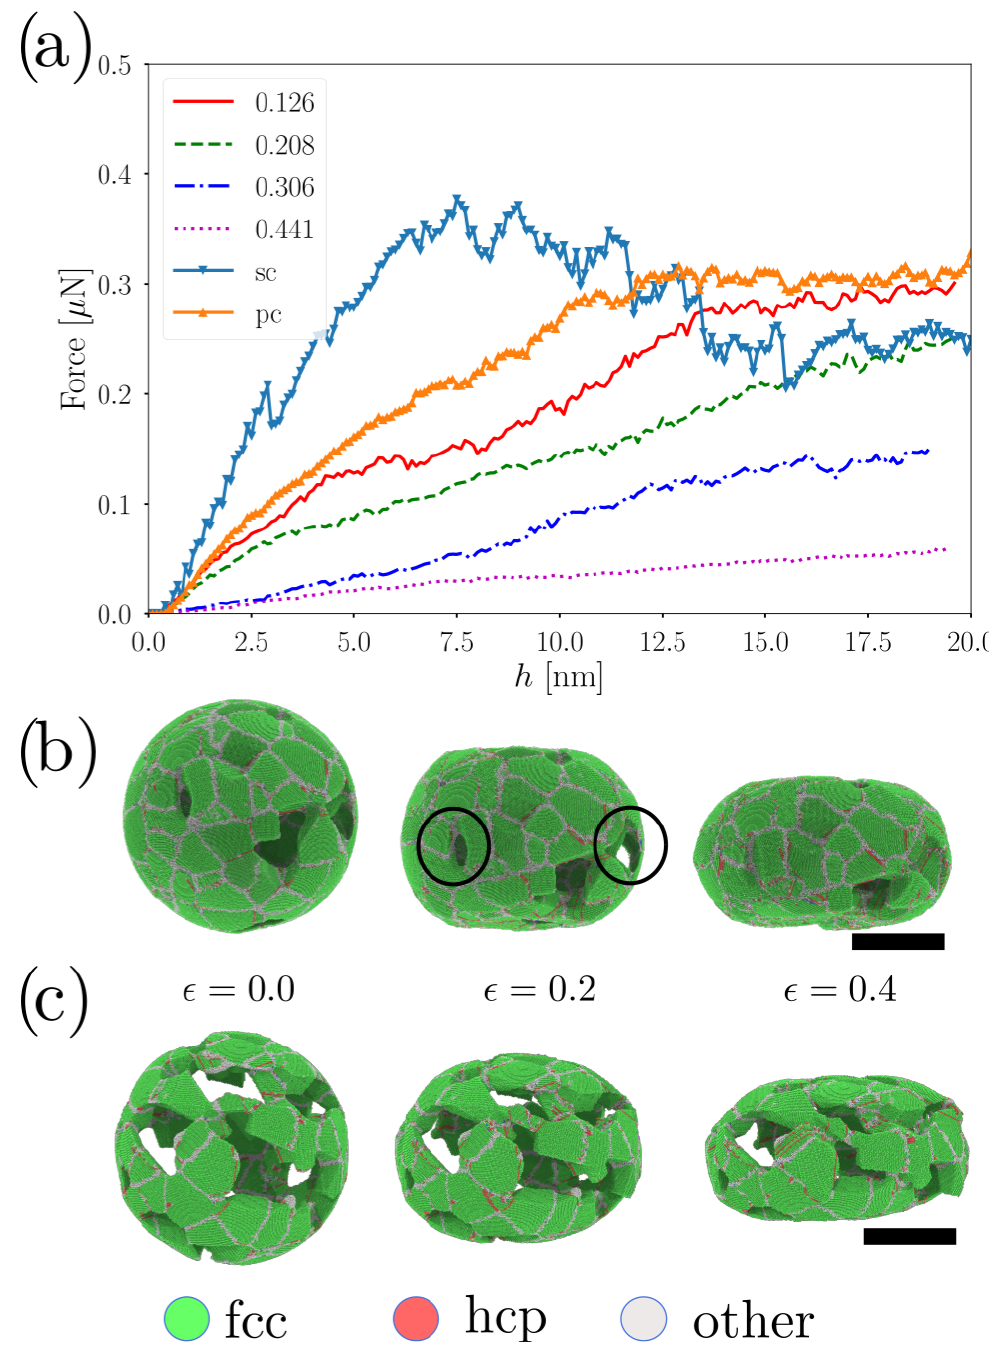
Figure 1. ( a ) Force vs. depth curves for different porous NS. ( b , c ) CNA at different strains for φ = 0.208 and φ = 0.441, respectively. Circles, color legend of CNA. Scale bars correspond to 15